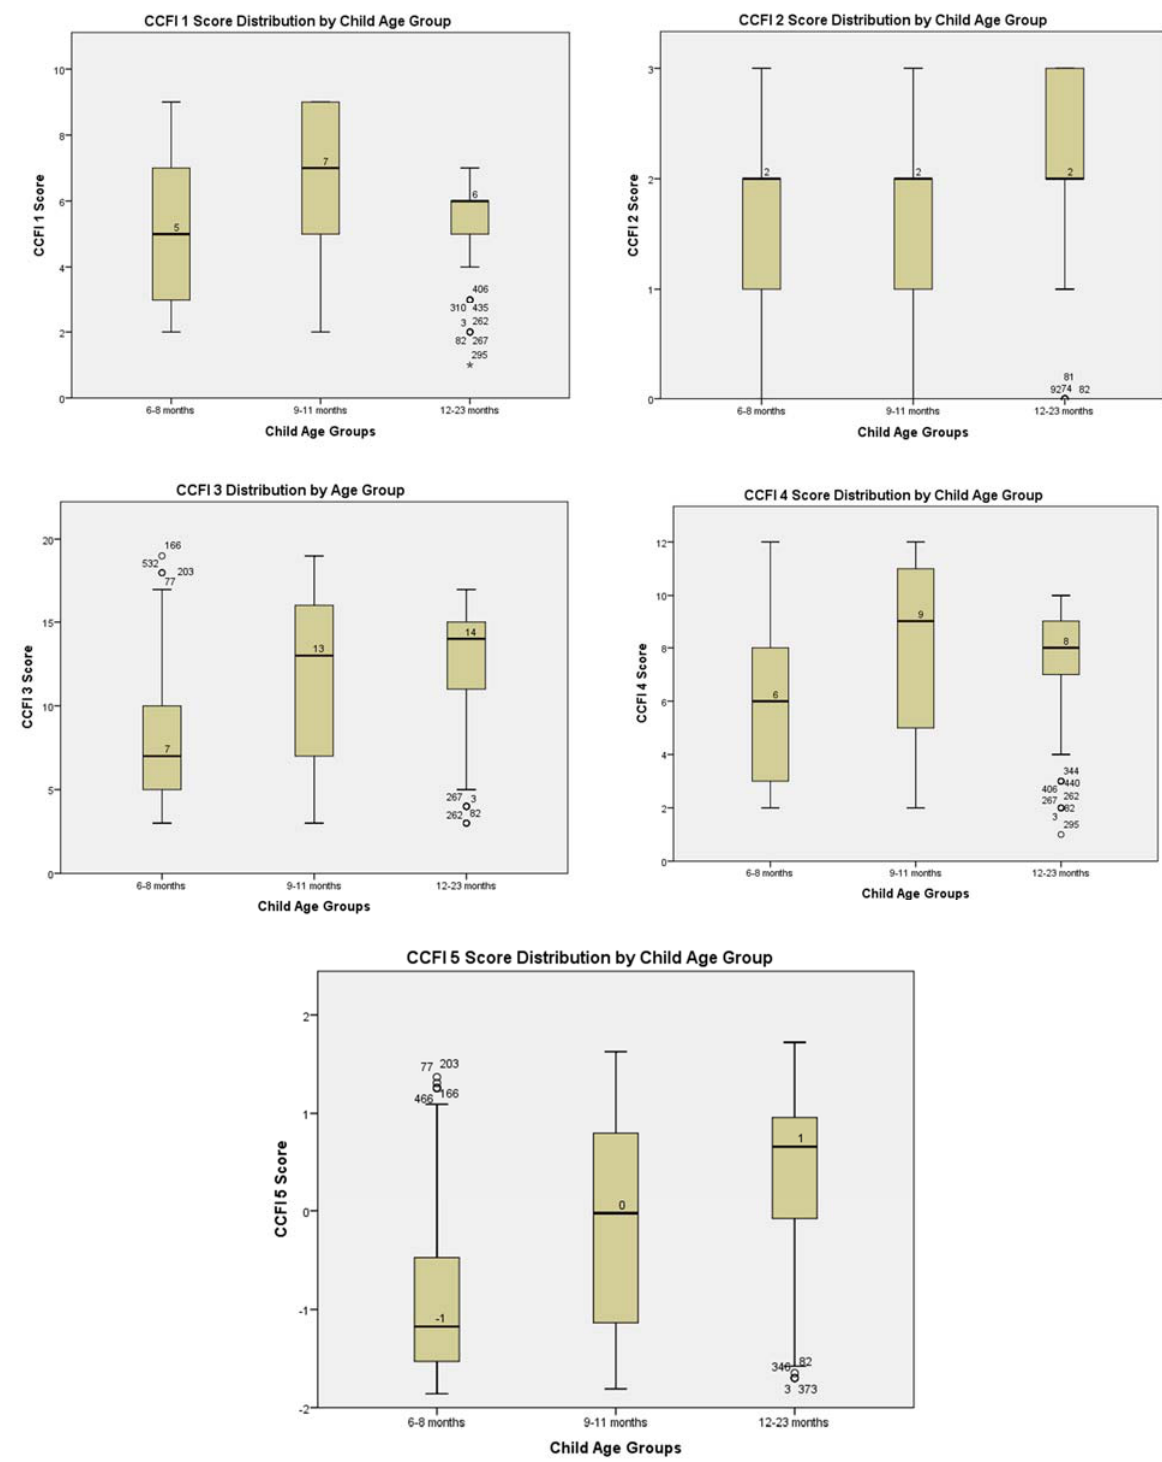
Figure 1. Box ‐ whisker plots showing the distribution of CCFI scores by child age groups and uni ‐ variate outliers (° regular outlier; * extreme